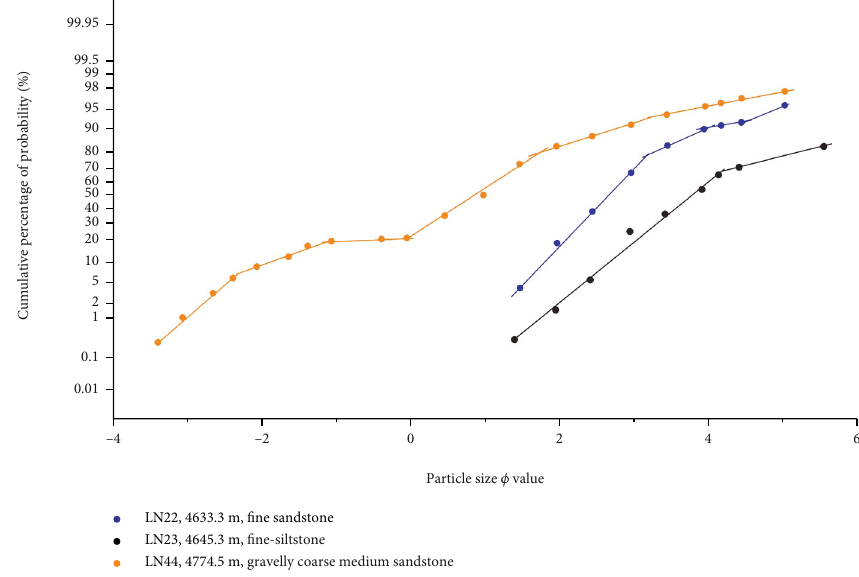
Figure 4: Cumulative probability curve of typical sample particle size from the TIII1 sand group in Sangtamu Oil fi